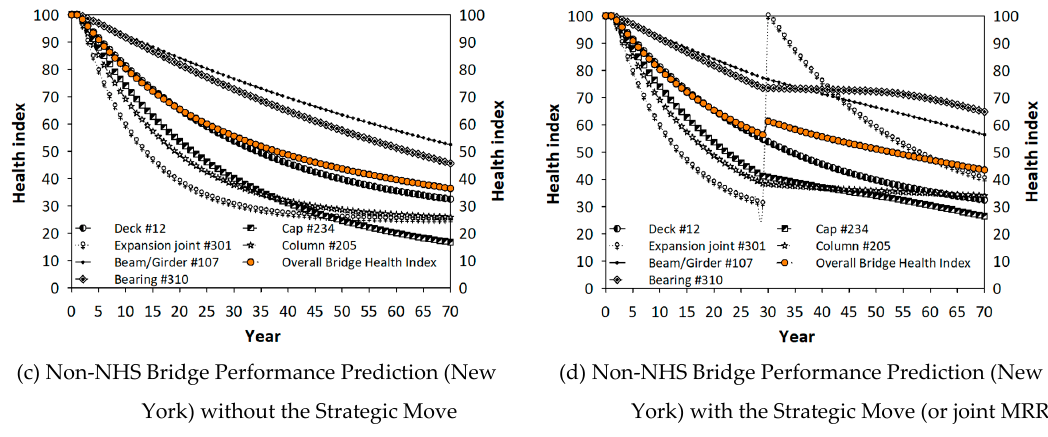
Figure 15. National Highway System (NHS) vs. non-NHS bridge in New York.